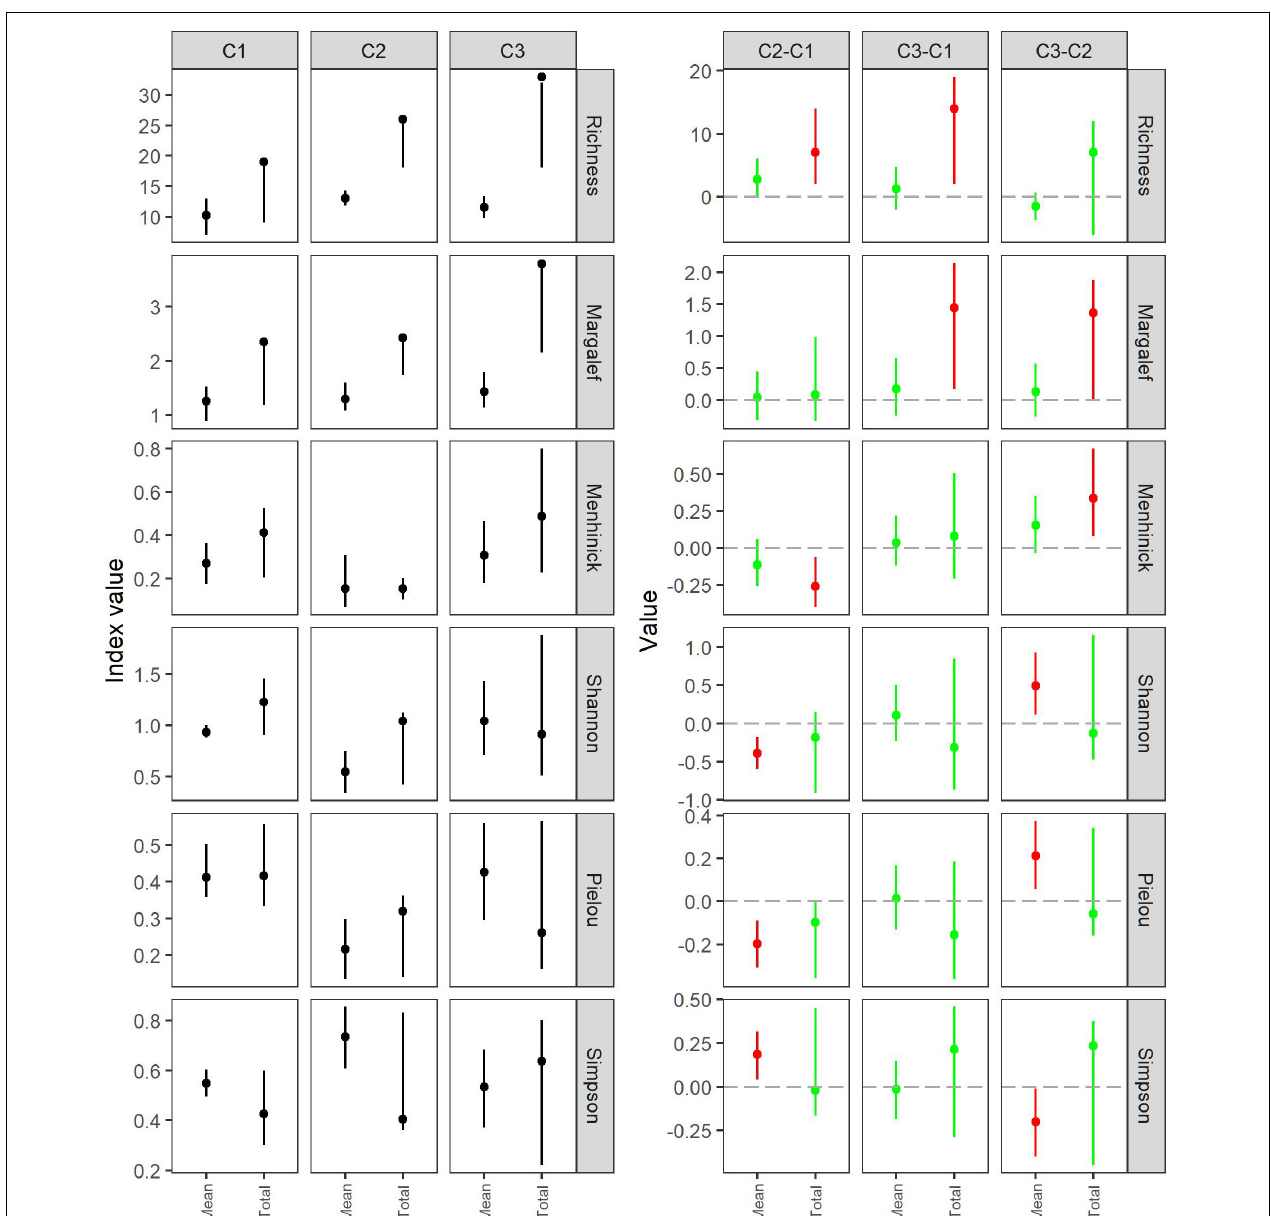
FIGURE 3 | Mean and total values for different biodiversity indices estimated for each cruise (left) and pairwise difference in biodiversity index values (deltas) between cruises (right) . Error bars represent 95% confidence intervals (CI). Red circles and corresponding CI highlights significant difference between the two stations, whereas green circles and their CIs represent stations without significant difference in biodiversity index